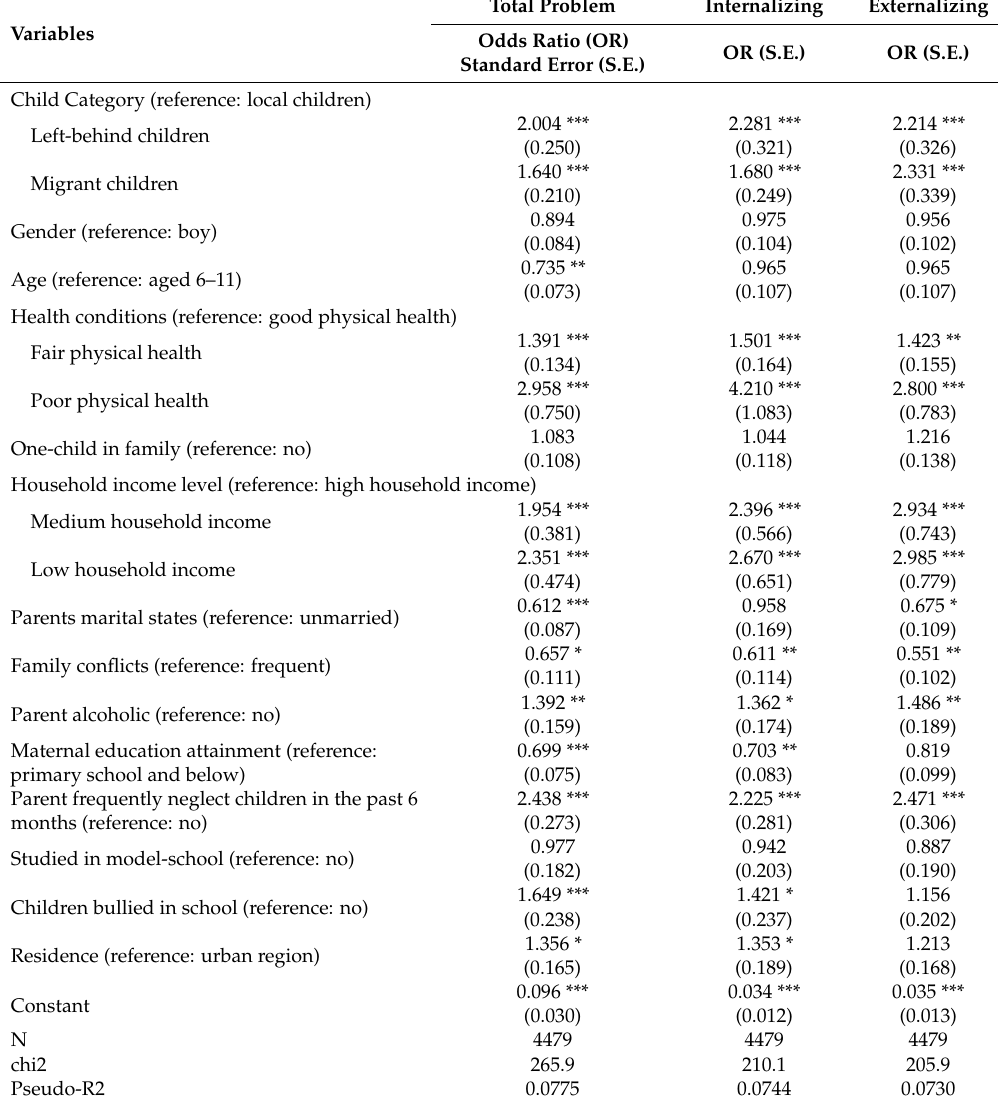
Table 5. Regression findings: total problem, internalizing and externalizing behavioral problem. Total Problem Internalizing Variables